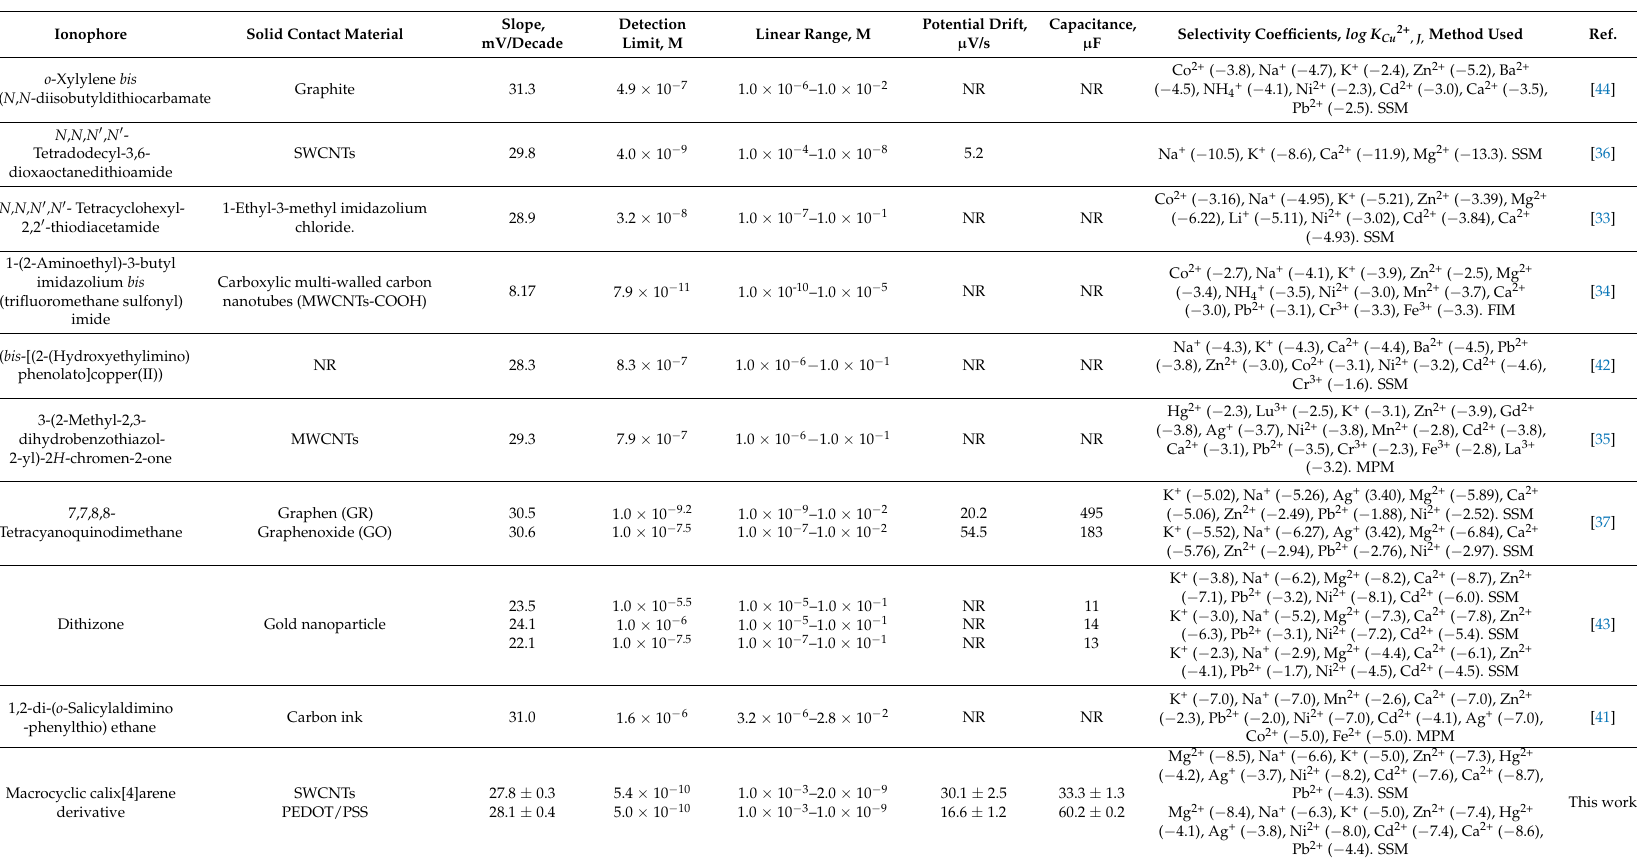
Table 5. Comparison of the potentiometric characteristic response of the presented ISEs and other previously reported solid contact Cu 2+ -ISEs. Ionophore Solid Contact Material Slope, mV/Decade Detection Limit, M Linear Range, M Potential Drift, µ V/s Capacitance, µ F Selectivity Coefficients, log K Cu2+ ,J, Method Used